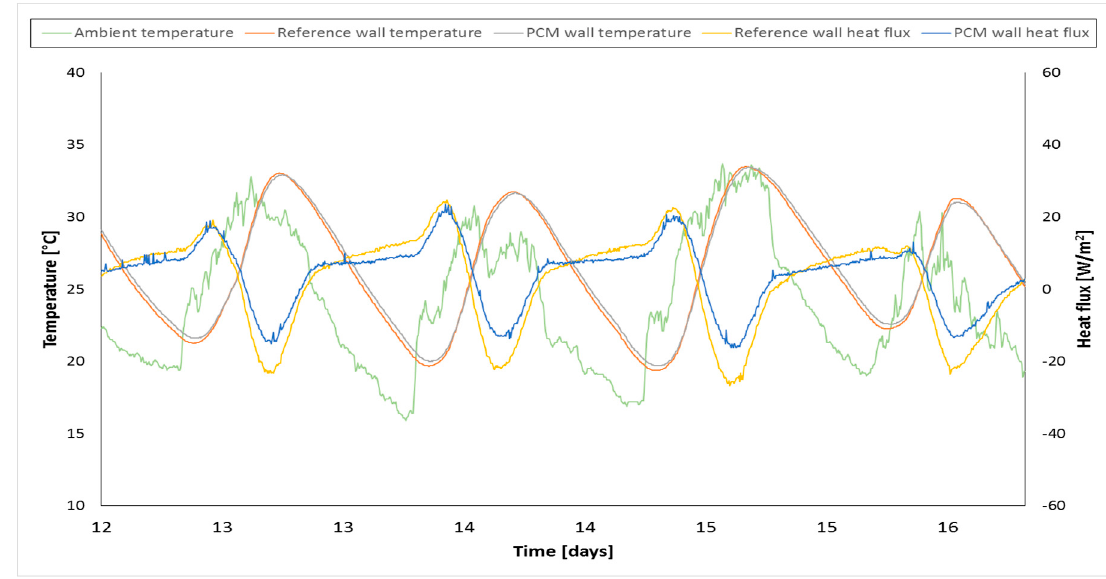
Figure 7. Comparison between interior surface south wall temperatures, outdoor temperature and heat flux through the south wall for both cubicles. Summer (July).